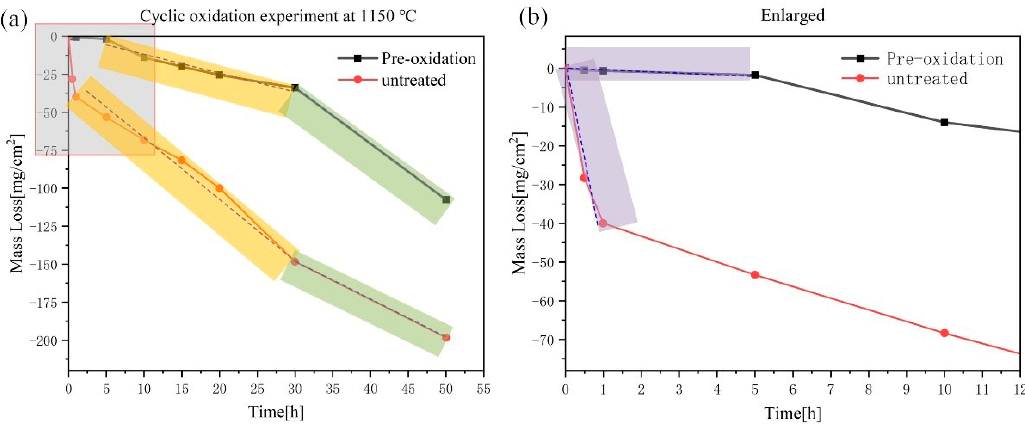
Figure 6. Oxidation kinetic curve at 1150 ◦ C for 50 h in air: ( a ) oxidation mass loss curves of pre-oxidized and untreated samples; ( b ) local enlarged part in ( a ).